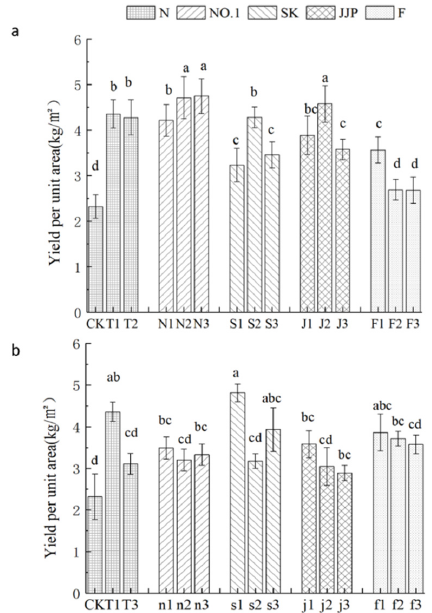
Figure 1. Effects of different fertilization treatments on the yield of cabbage. Note: ( a ) 20% reduc- tion of total nitrogen with different bio-organic fertilizer, ( b ) 30% reduction of total nitrogen with different bio-organic fertilizer. Different small letters represent a significant difference at 0.05 level by Duncan’s